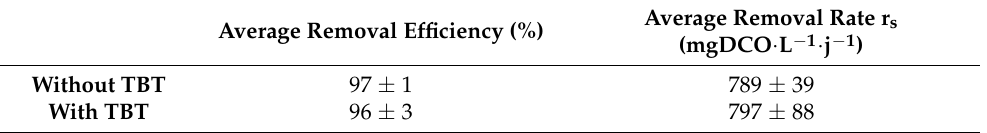
Table 1. Average removal efficiency and COD removal rate values (r s ) measured during the